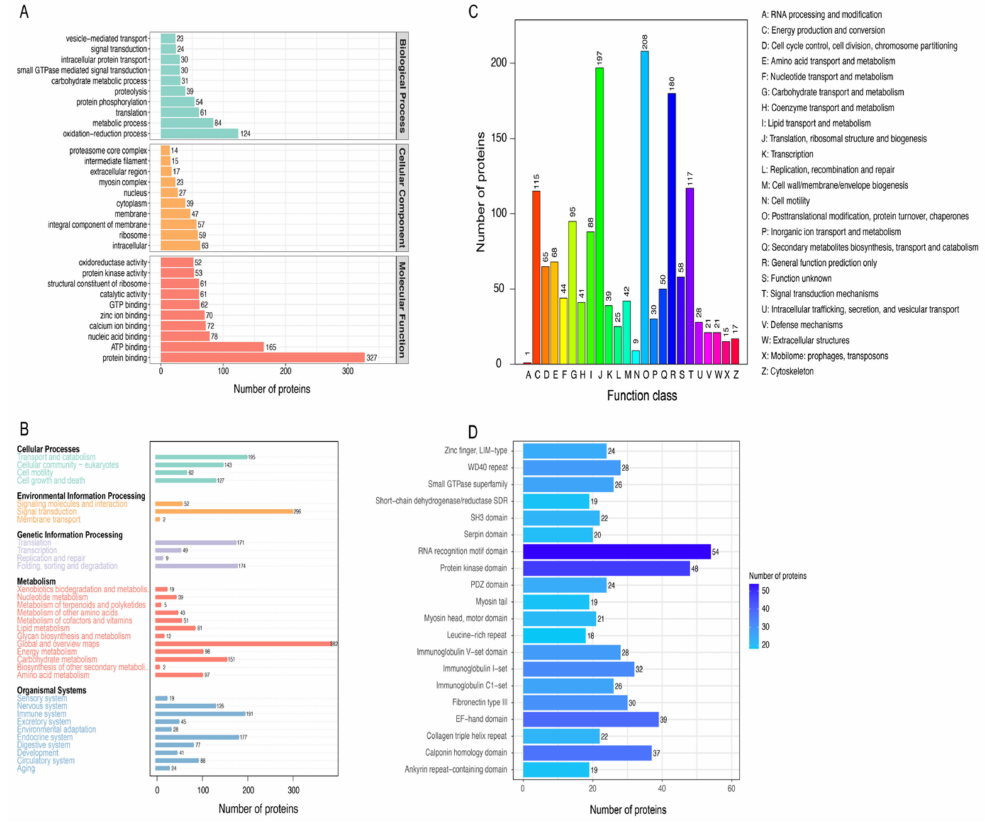
Figure 2. Functional annotation of the identified proteins. ( A ) GO annotation of the identified proteins. The X–axis represents the number of proteins, and the Y–axis represents the name of the GO term. ( B ) KEGG annotation of the identified proteins. The X–axis displays the number of proteins, while the Y–axis represents the name of the pathway. ( C ) COG annotation of the identified proteins. The X–axis represents the functional classification in the COG database, and the Y–axis represents the number of proteins. ( D ) IPR annotation of the identified proteins. The X–axis displays the number of proteins, while the Y–axis displays the name of the protein